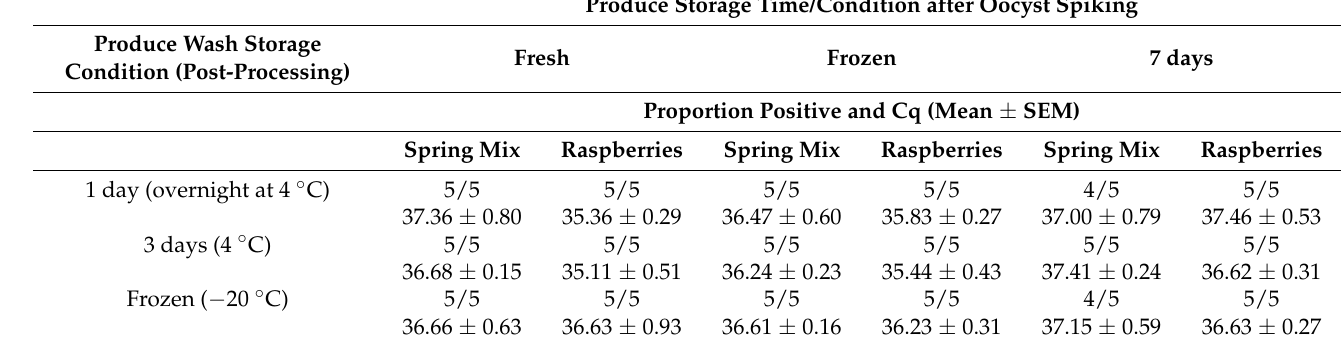
Table 3. Impact of produce and wash storage time or condition on the proportion positive for the spring mix and raspberries.